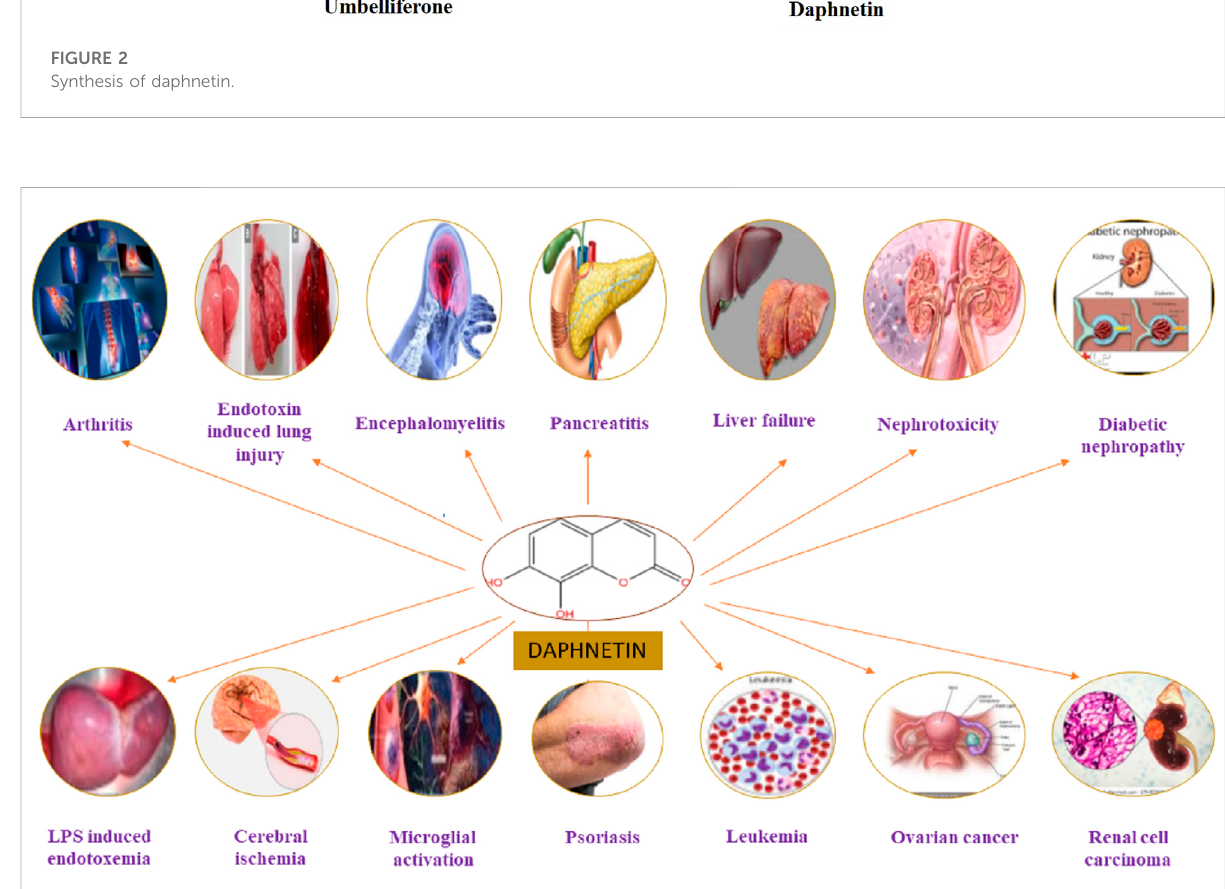
FIGURE 3 Pharmacological and therapeutic targets of